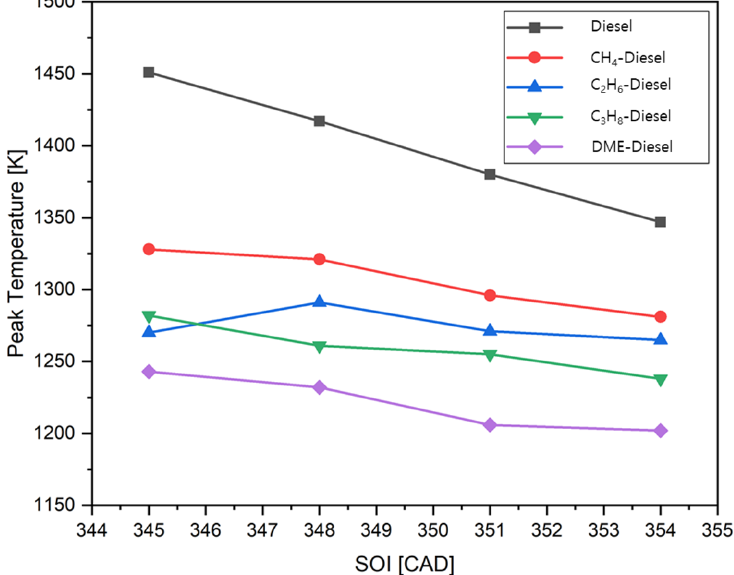
Figure 23. Peak temperature according to pilot SOI angles in all combustion modes.